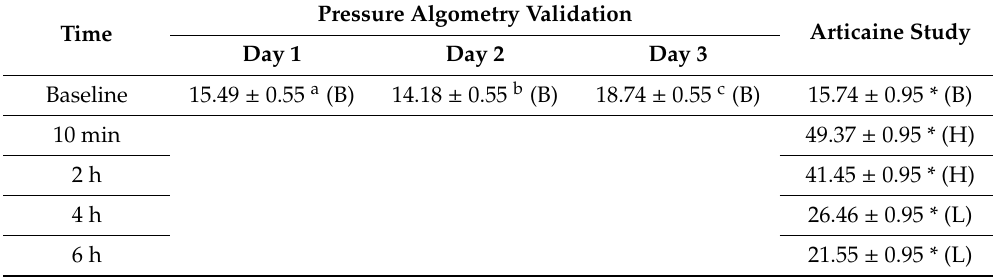
Table 1. The least-squares means (±SEM) of MNT (N) for algometry validation and articaine study. The values below depict MNT disregarding antler side and site. N = 40 animals for the validation study, and 10 for articaine study.